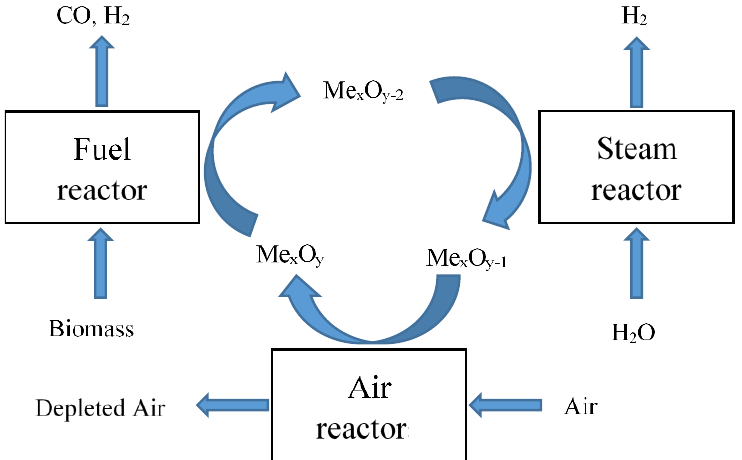
Figure 5. Process scheme of three-reactor system for BCLG.